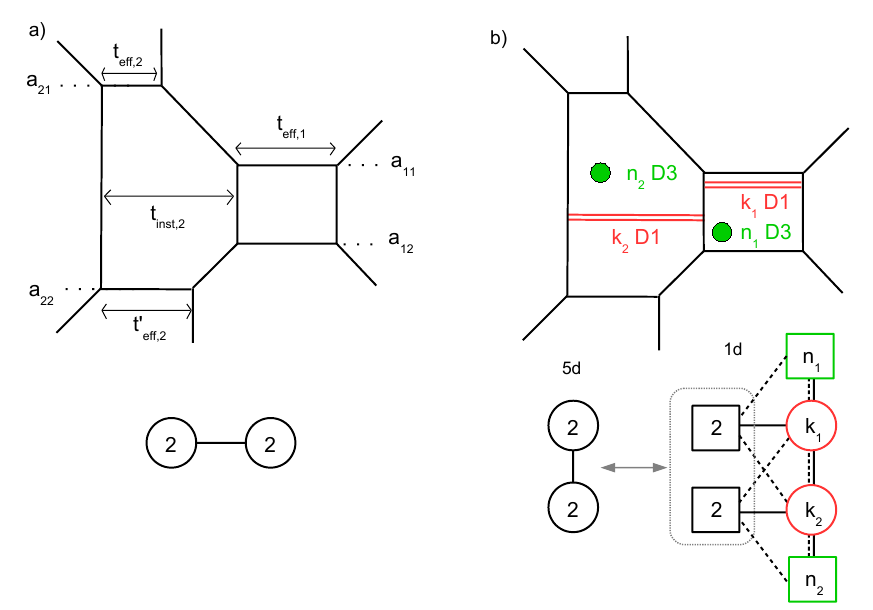
Figure 12 . a) Brane realization of the SU(2) (cid:25) (cid:2) SU(2) (cid:25) theory. b) Brane setup ADHM quiver SQM for the ( k 1 ; k 2 )-instanton sector in the presence of an ( n 1 ; n 2 ) D3 branes SQM loop.